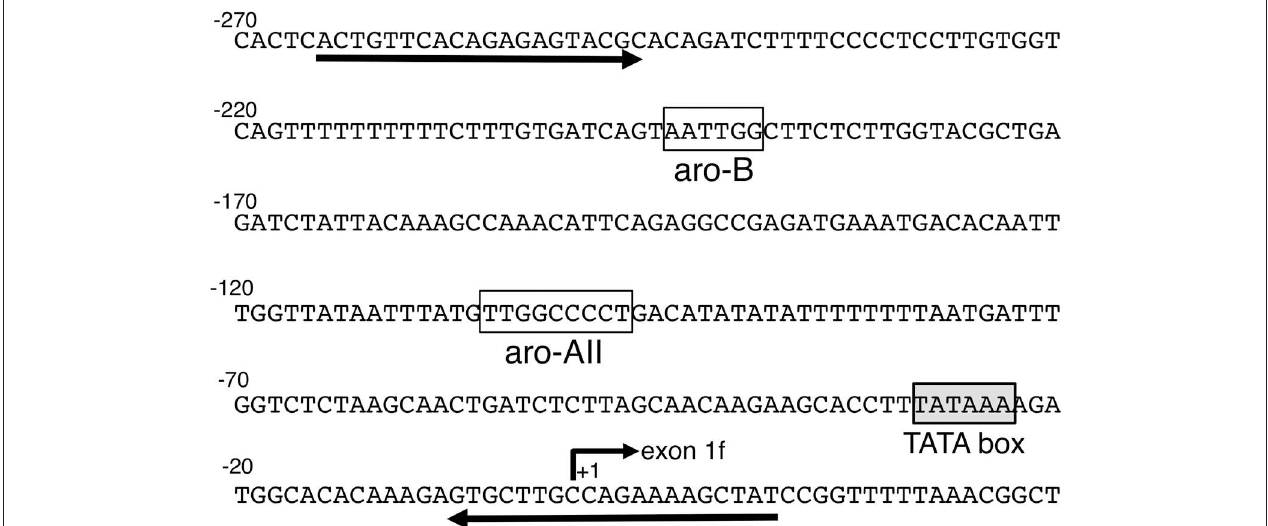
FIGURE 1 | Brain-specific exon 1 and its promoter region in the mouse aromatase gene. The number + 1 corresponds to a potential transcription start site. A TATA box is shown in the shadowed box. The open boxes indicate the aro-AII and aro-B sites found in previous studies (27). The two primers used in the chromatin immunoprecipitation assay are also indicated in the figure by the